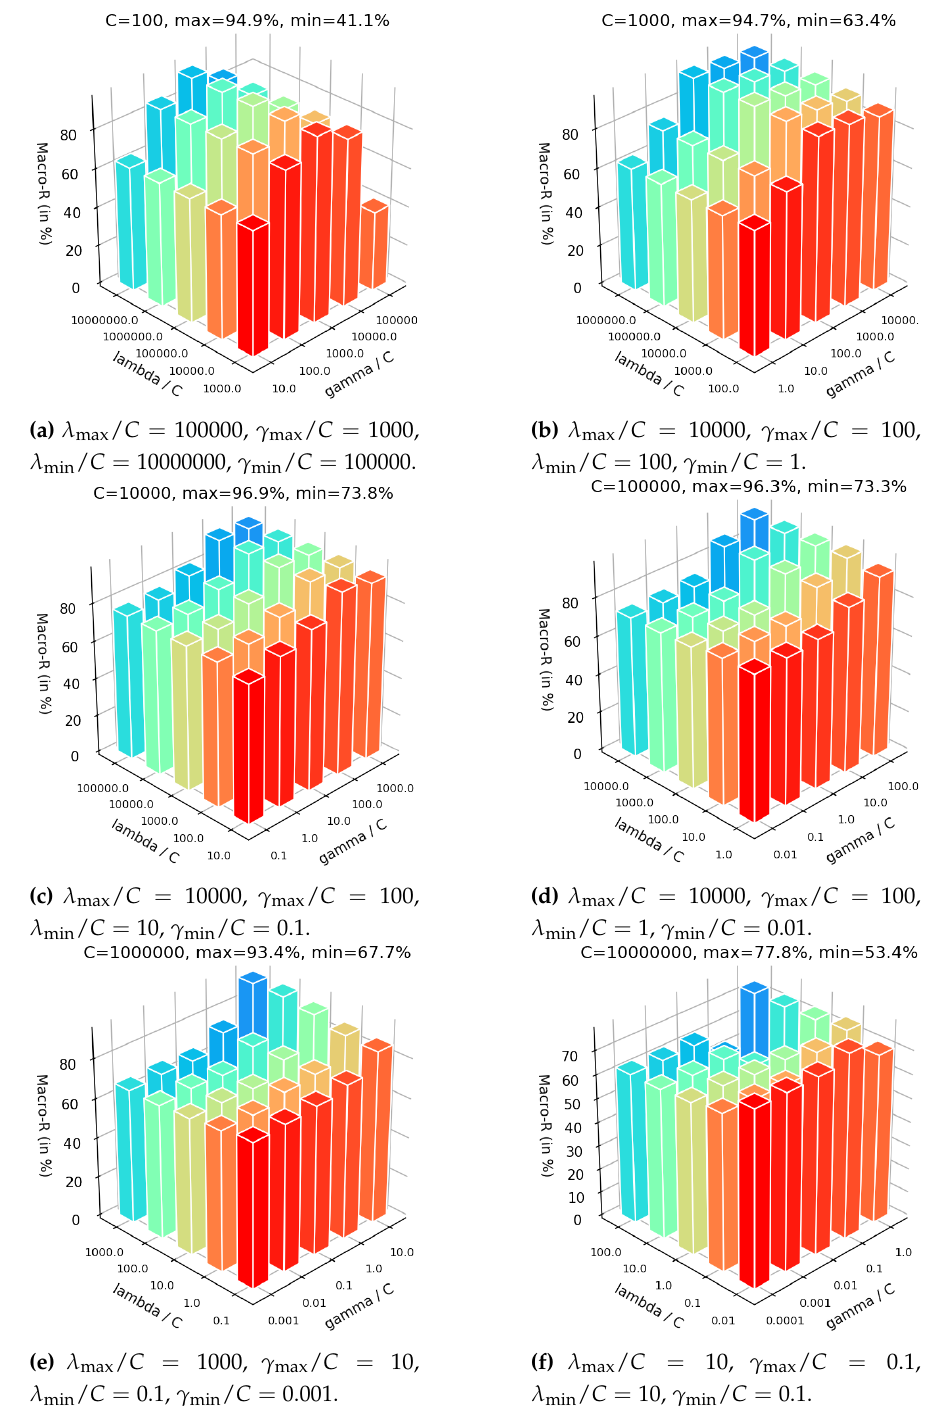
Figure 7. Classification accuracies of JDA-S2ELM on dataset 1 over the variation of C , λ and γ